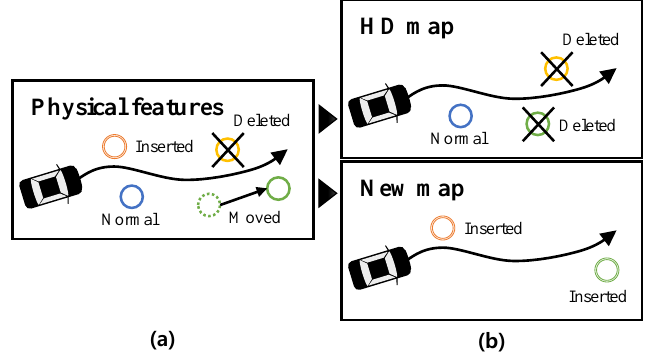
Figure 2. Definition of the HD map changes. ( a ) physical world. ( b ) HD map m HD and new map m new . The map component can be classified into m HD { normal } , m HD { delete } , m HD { insert }